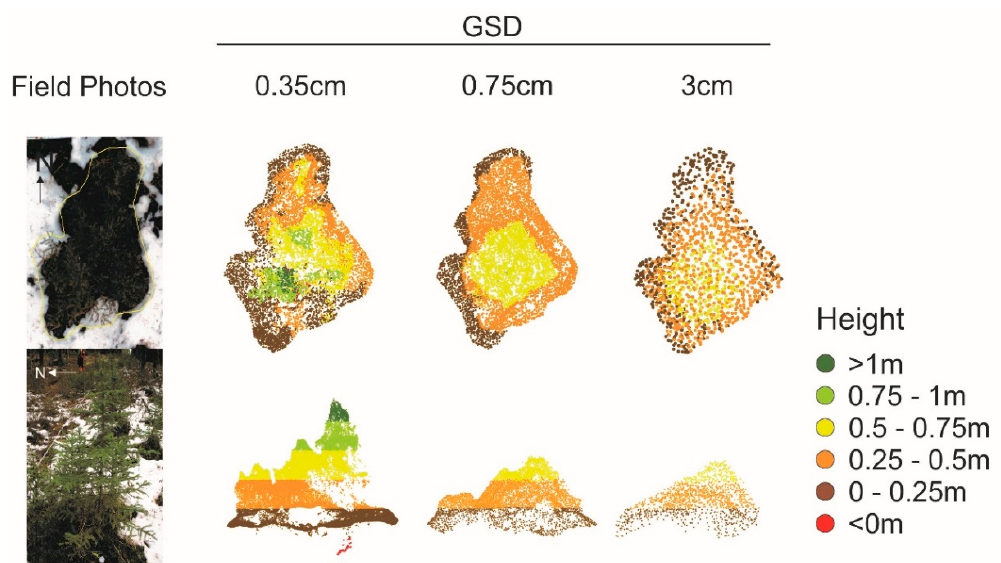
Figure 5. An example illustrating relative point densities, 3D reconstruction detail, and height estimation for a cluster of spruce seedlings (drone and ground photos on the left) using each of the three ground sampling distances (GSD) studied. Points colored according to their height. Note that as GSD coarsens, the corresponding point cloud “flattens” (see also Video S1).